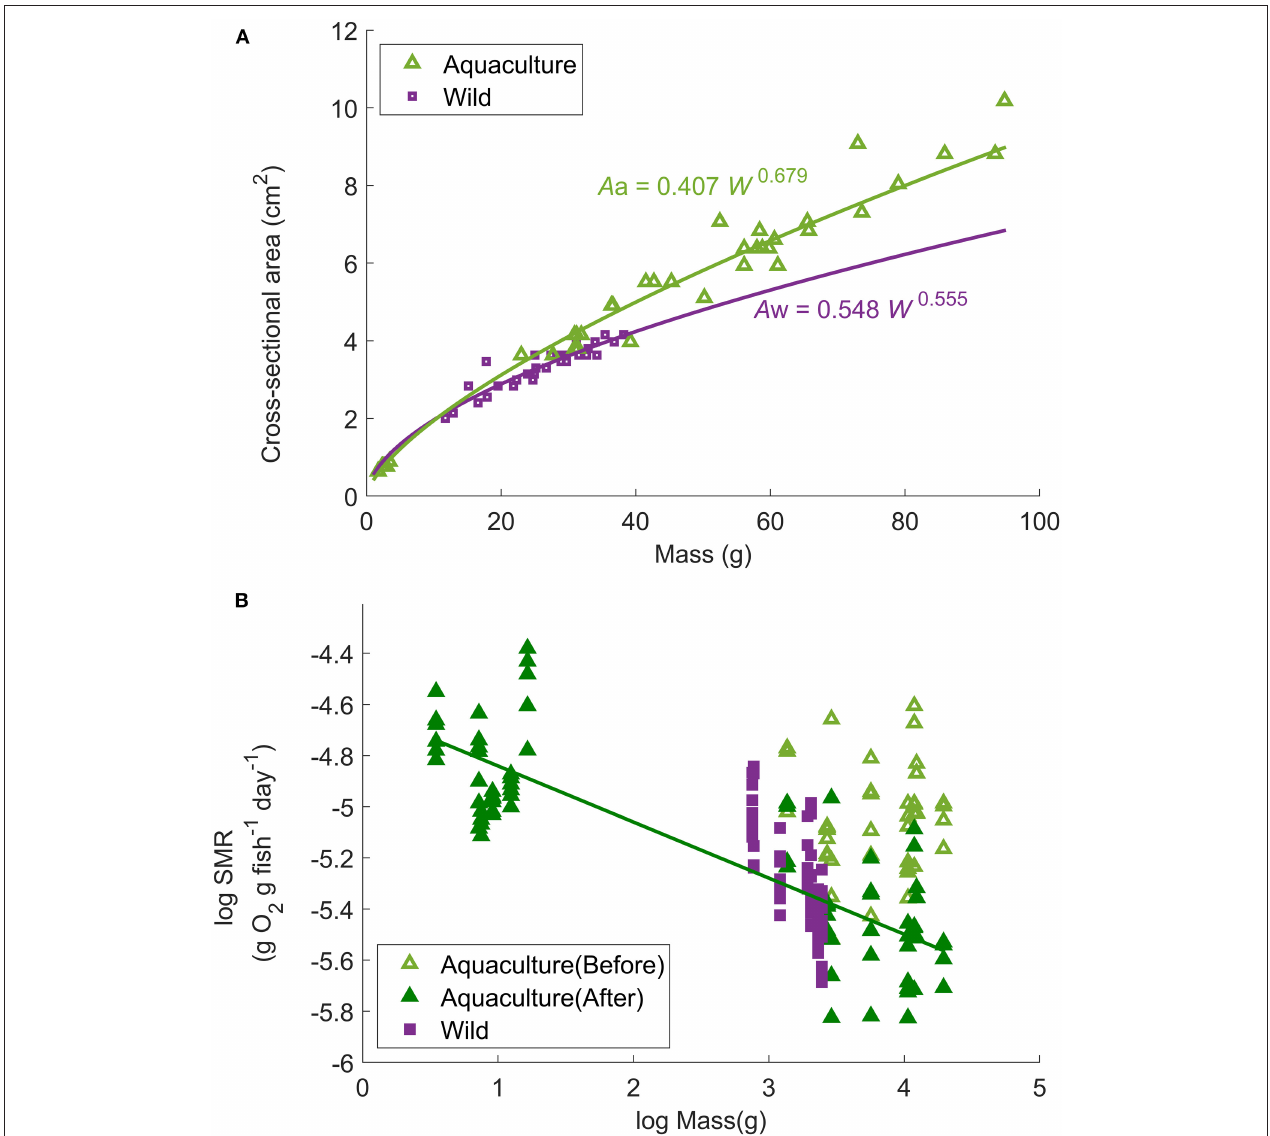
FIGURE 2 | (A) Relationship between fish mass ( W , g) and cross-sectional area at the largest girth ( A , cm 2 ) of all Northwest stock individuals used in the experimental trials. The curves represent the power regressions: A a = 0.407 W 0.679 ( r 2 = 0.993, p < 0.0001, n = 44) for aquaculture-reared individuals and A w = 0.548 W 0.555 ( r 2 = 0.854, p < 0.0001, n = 30) for wild-caught individuals. (B) Relationship between standard metabolic rate and body mass ( W , g) of aquaculture-reared large juveniles before and after correction (non-corrected = light green open triangle; corrected = dark green solid triangle) in comparison to wild-caught (non-corrected, purple solid square) individuals at 18 ◦ C. The solid line represents the linear regression of logarithmic fish mass ( W , g) and logarithmic activity effected removed mass-specific M O2 : log (SMR 18 ) = − 0.219 log ( W ) – 4.62 ( r 2 = 0.616, p < 0.0001).